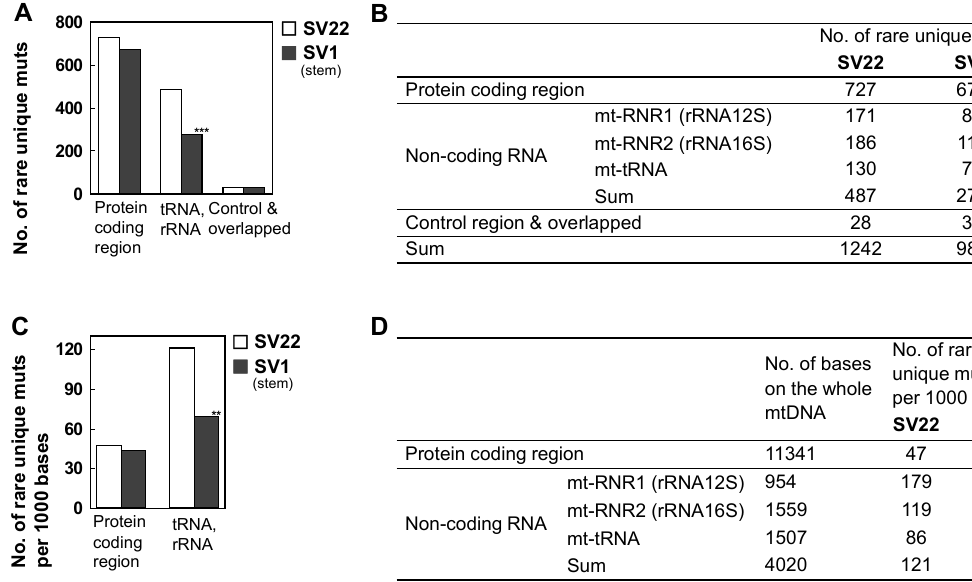
Figure 4. Number of rare unique mutations considered (individually and per 1000 bases) by genome positional category in the whole mtDNA. Number of rare unique mutations by positional category ( A , B ) and number of rare unique mutations per 1000 bases by positional category ( C , D ) were calculated for SV22 (immortalized non-stem) and SV1 (immortalized stem) cells. Only genome positions that had a DCS read depth of ≥ 100 in both samples were considered. Significant differences in numbers of rare mutations between the two groups are indicated (* p < 0.05, ** p < 5 × 10 −4 , and *** p < 5 × 10 −10 ) by the Chi-Square test.